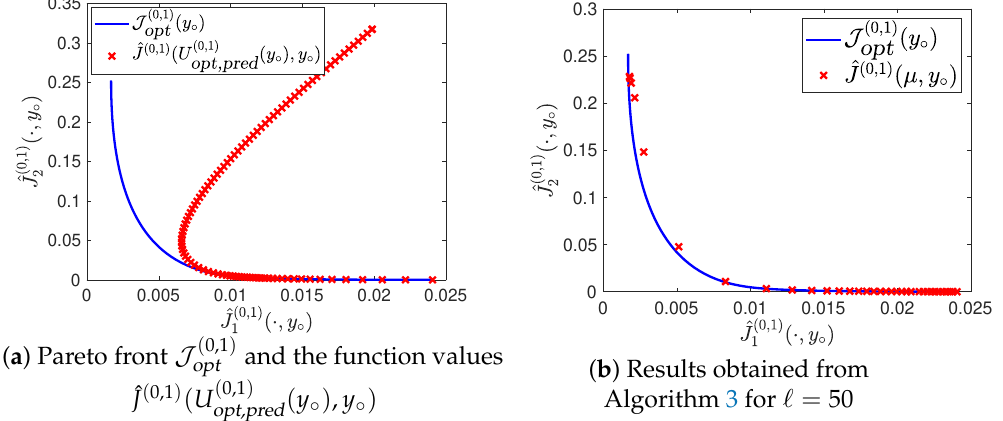
Figure 3. Comparison of the predictive multiobjective optimal control and Algorithm